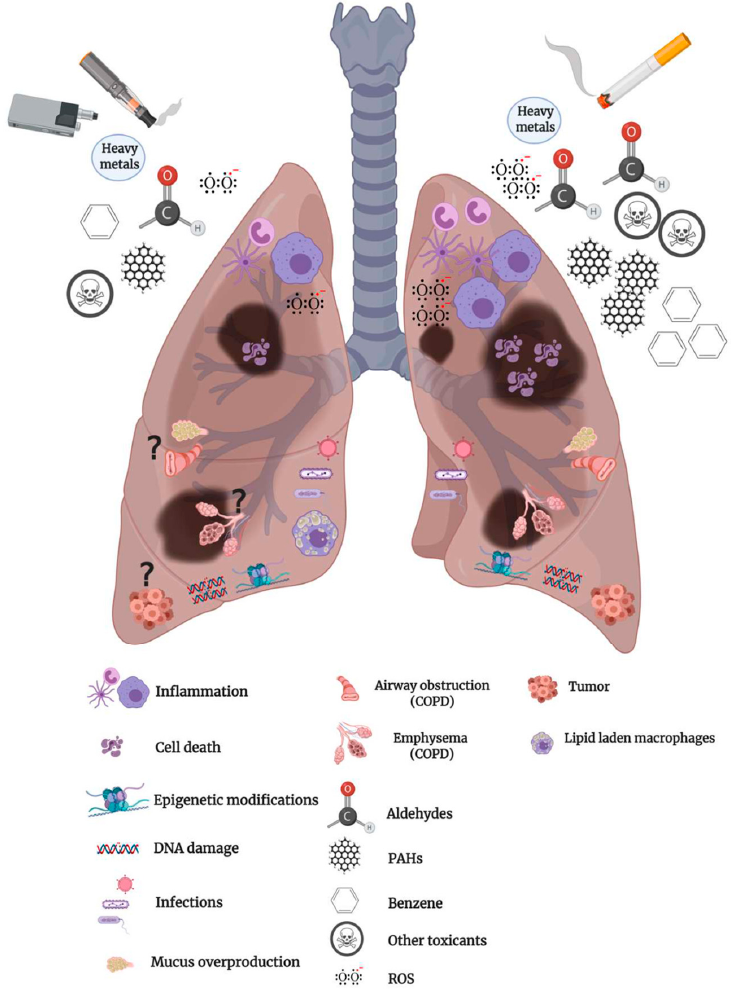
Figure 1. The known and unknown health effects of vaping in comparison to cigarette smoke. The major toxic effects of compounds found in cigarette smoke (Right lung) and in vaping aerosols (Left lung) are lunginflammation, oxidative stress, cell death, impaired immune response, DNA damage and epigeneticmodifications. The respiratory diseases caused by cigarette smoke (lung cancer, COPD [emphysema and/orobstruction of airways]) are not yet established to be caused by vaping (represented by question marks in theleft lung). The presence of lipid ‐ laden macrophages is a feature predominantly associated with vaping products containing THC and has been a feature of EVALI.